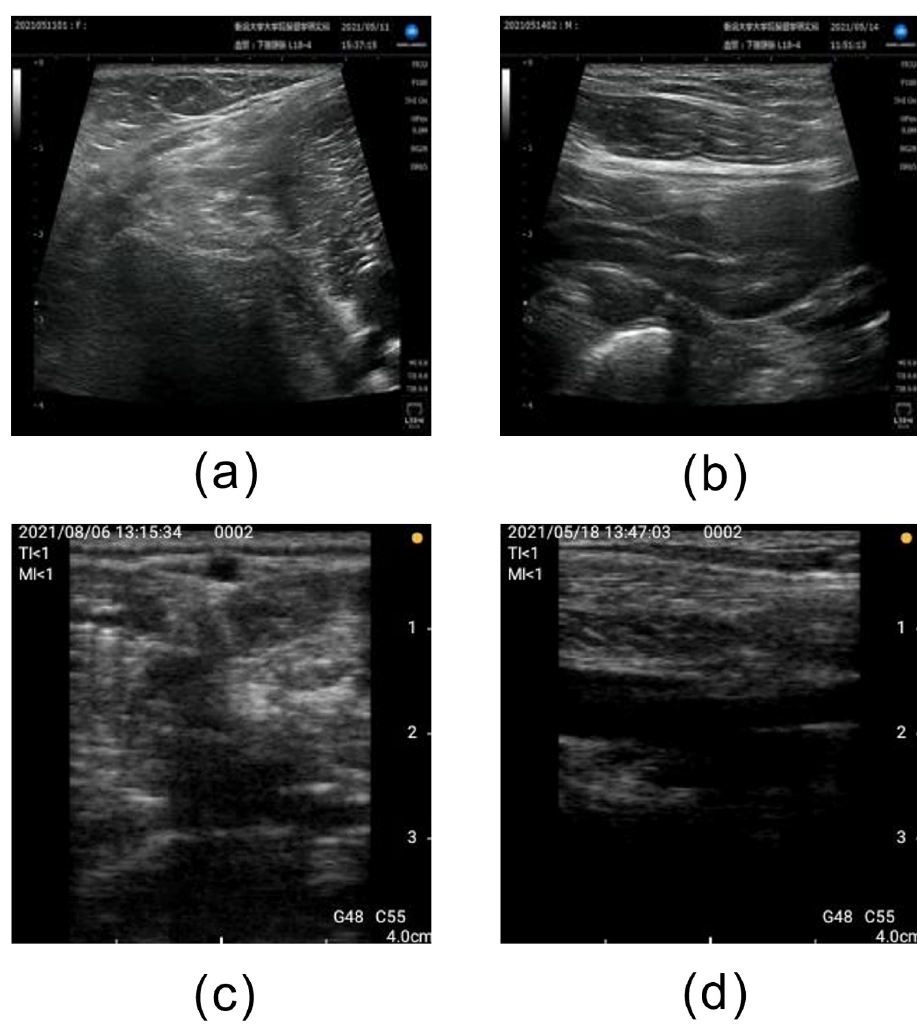
Fig 8. Examples of correctly classified Moderately Satisfactory images. (a) Short axis acquired by stationary ultrasonography equipment, (b) Long axis acquired by stationary ultrasonography equipment, (c) Short axis acquired by portable ultrasonography equipment, and (d) Long axis acquired by portable ultrasonography